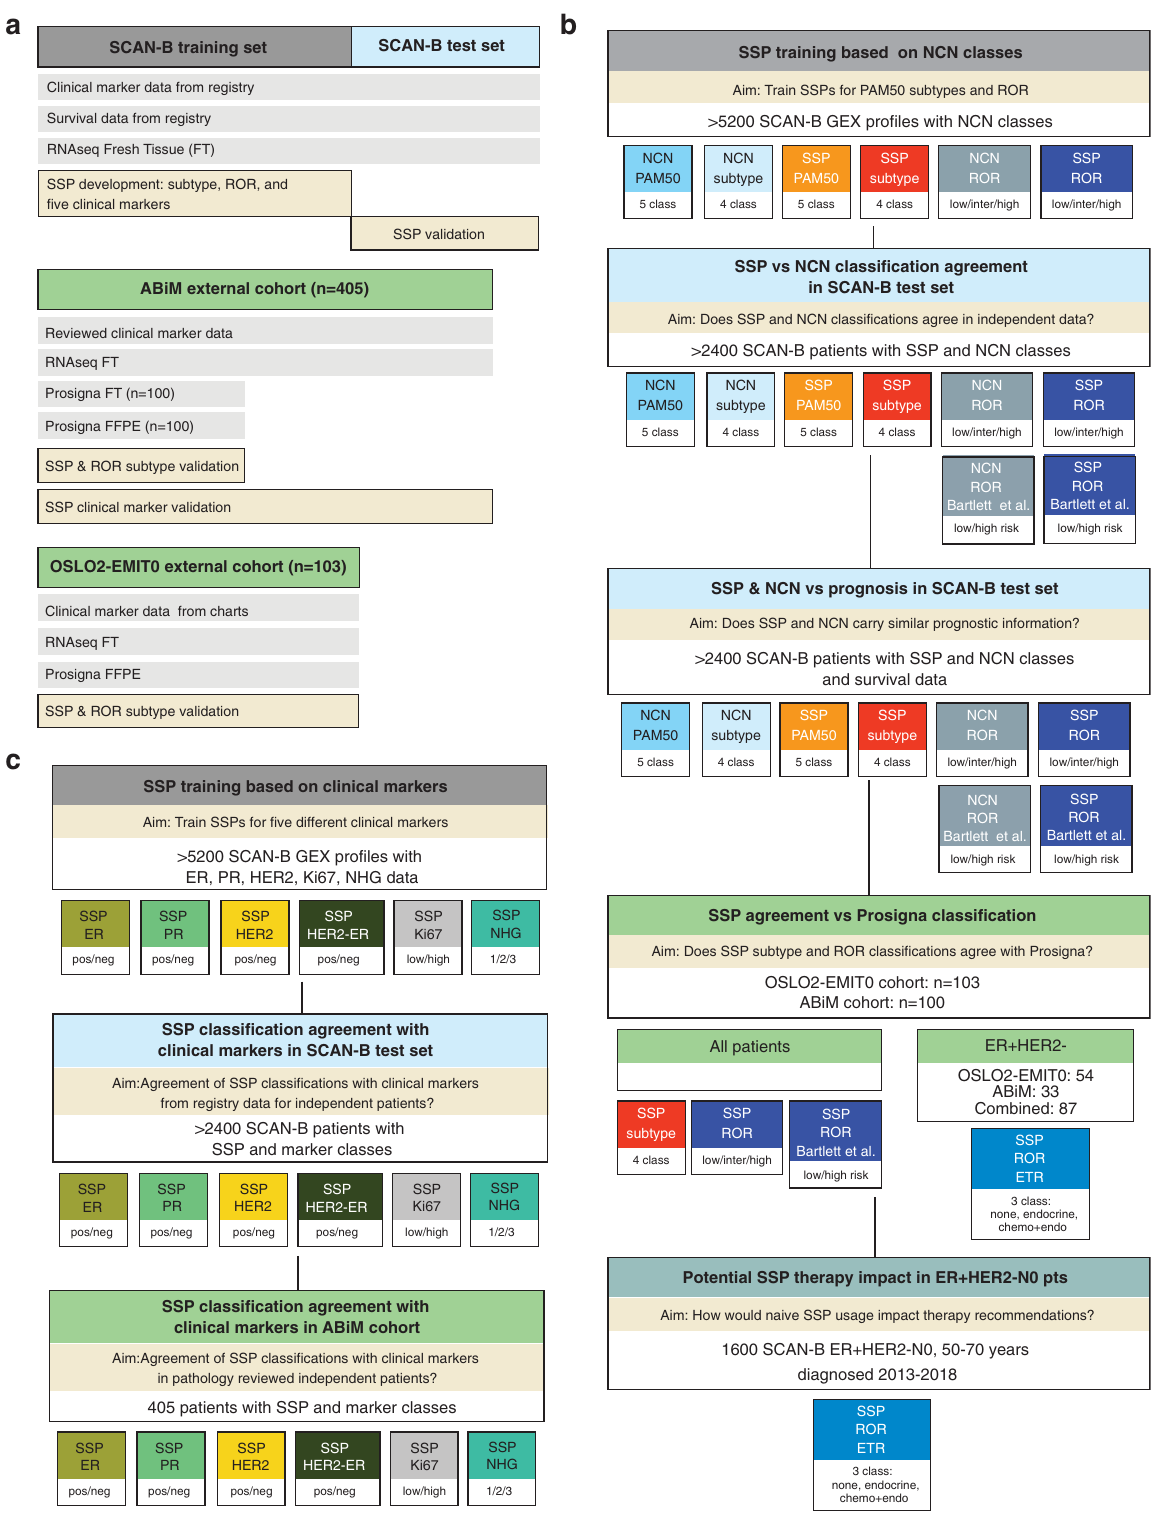
Fig. 1 Outline of the study. a Study cohorts: SCAN-B, ABiM, and OSLO2-EMIT0. Available data types and usage outlined. FT fresh-frozen tissue, FFPE formalin- fi xed paraf fi n-embedded tissue. b Scheme for development and validation of SSP models for molecular subtypes and ROR versus NCN equivalents. Scheme outlines created SSP models and their usage in different cohorts. NCN and SSP 4-class subtype models include Basal-like, HER2-enriched, Luminal A and Luminal B subtypes. Binary SSP-ROR and NCN-ROR risk classes were created similar as described by Bartlett et al. 5 . An emulated 3-group SSP-based treatment recommendation (SSP ROR ETR) was created based on published Norwegian guidelines for Prosigna usage and applied to relevant SCAN-B patients based on guidelines. c Scheme for development and validation of SSPs for clinical markers: ER, PR, HER2, Ki67, and NHG. Scheme outlines created SSP models and their usage in different